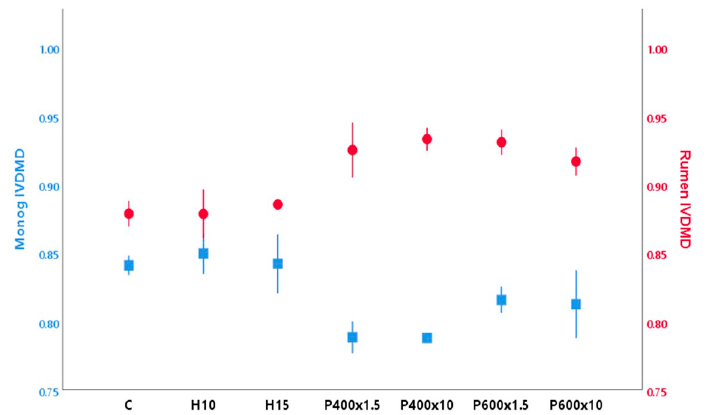
Figure 1. Mean values (± standard deviation) of BSFL in vitro true rumen ( ● ) and apparent monogastric total tract ( ■ ) dry matter digestibility after the application of different treatments.